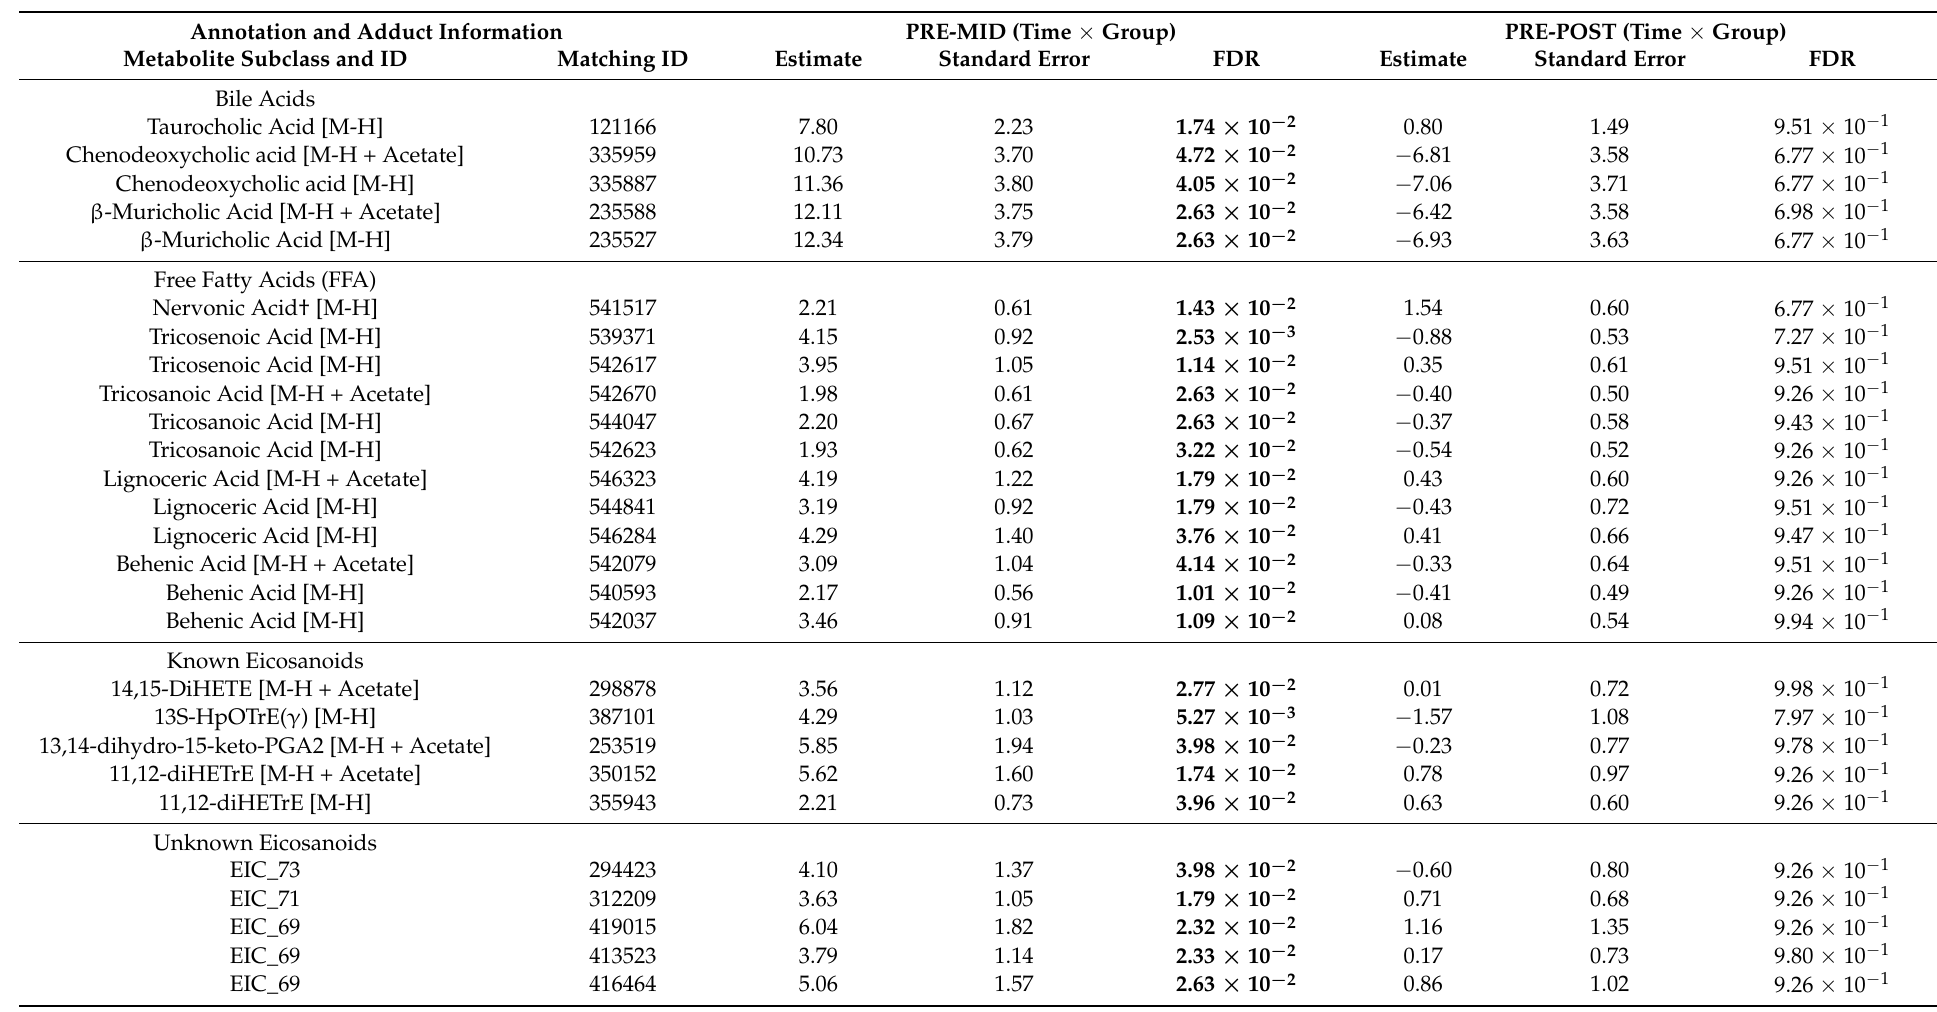
Table 1. The effect of intensive fat mass loss and fat mass regain on LC-MS metabolome in the diet group compared to control group (Time × Group) of physique study